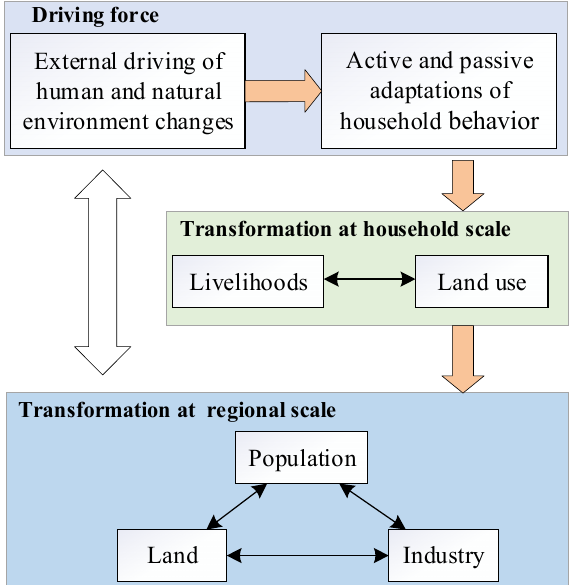
Figure 1. Conceptual model of rural transformation linking household scale and regional scale.